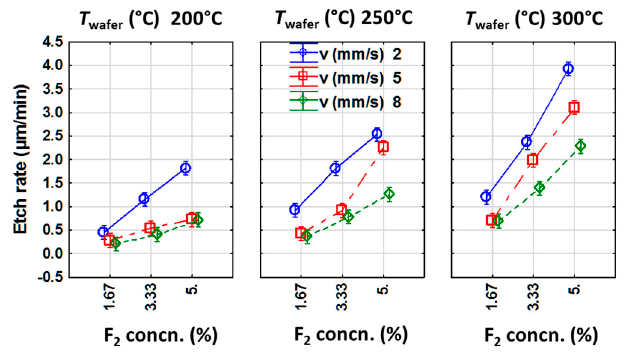
Figure 5. Plot of marginal means and confidence intervals showing interdependency of the most significant factors affecting etch rate. The lines are guides to the eye.